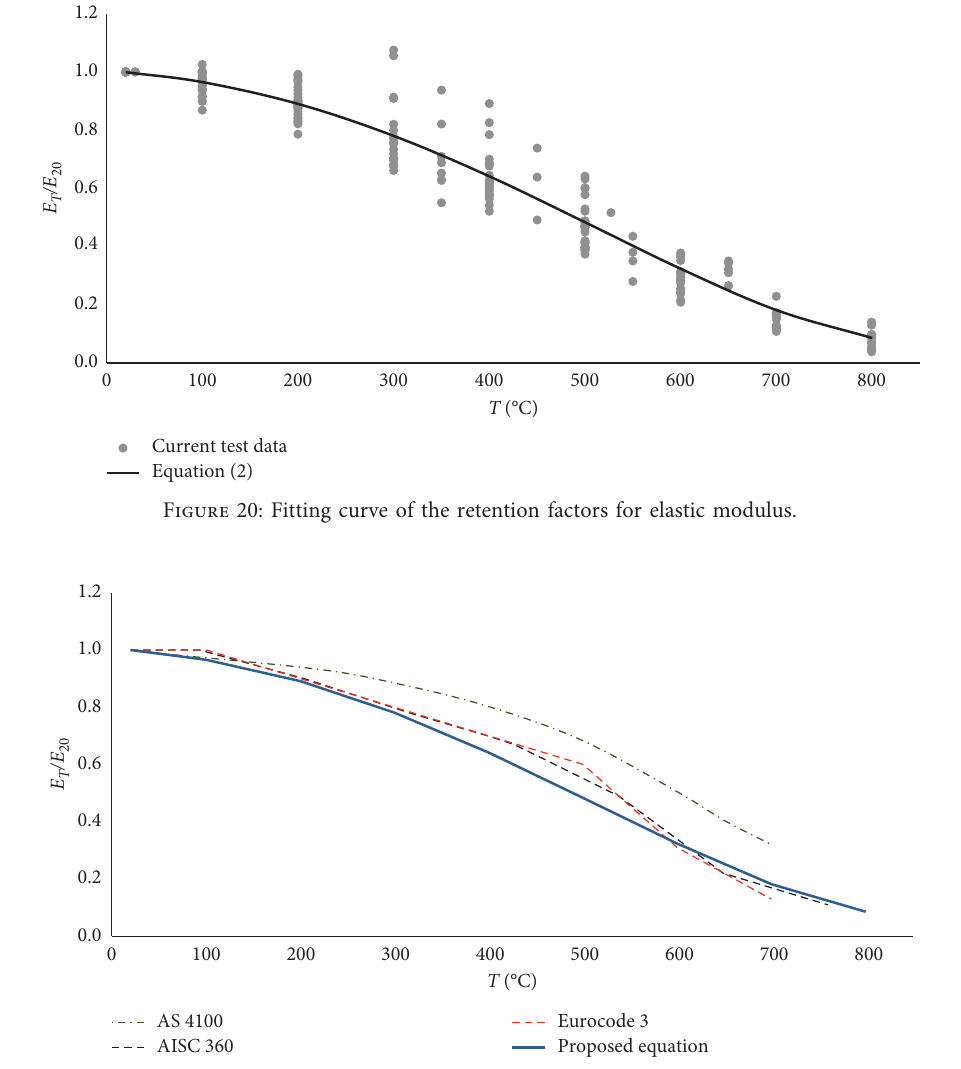
Figure 21: Comparison of the proposed equation curves with code curves for predicting elastic